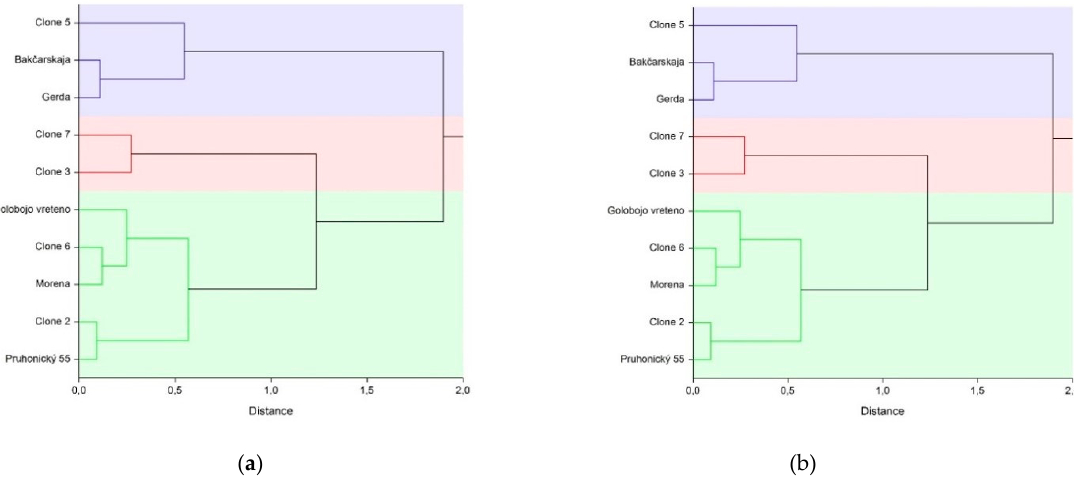
Figure 4. Cluster analysis based on TAA (equivalent to TROLOX mg L − 1 ) values, year 2018 ( a ) and 2019 ( b ).